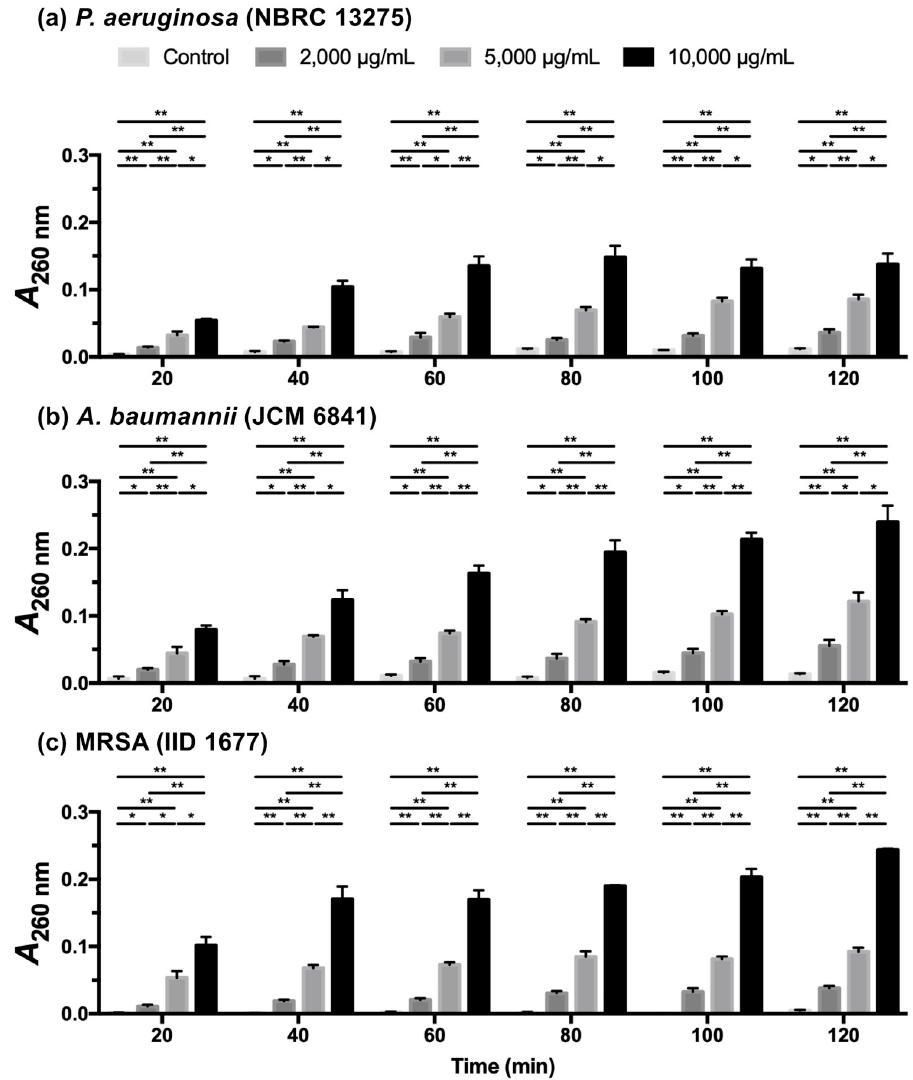
Fig 3. Cell membrane integrity assays. The measurement of the absorbance at 260 nm ( A 260 nm ) can be used to estimate the amount of nucleic acids released from the cytoplasm, which can be used to evaluate the cell membrane integrity. (a) Pseudomonas aeruginosa (NBRC 13275), (b) Acinetobacter baumannii (JCM 6841), (c) MRSA (IID 1677). The values are the mean ± SEM of triplicate measurements. � p < 0.05, �� p < 0.01 (unpaired